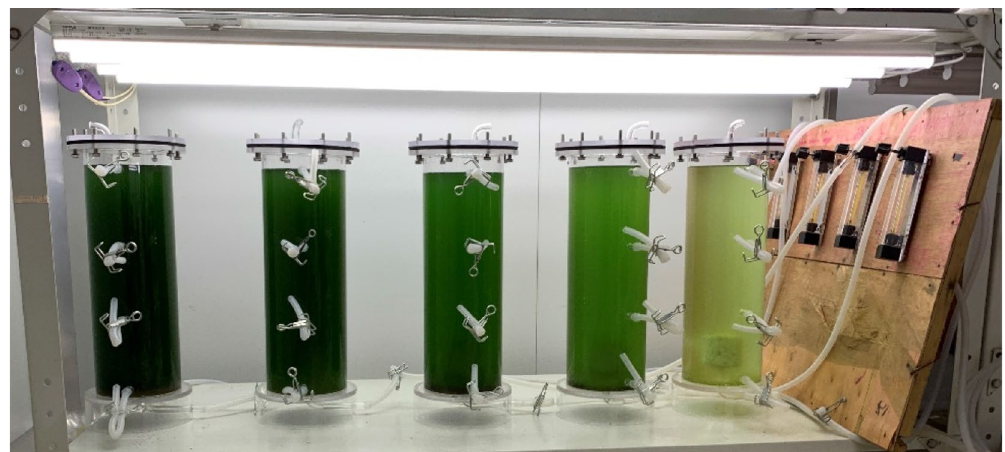
Figure 1. PSBR with Consortia with algae/sludge 10:1, 5:1, 1:1, 1:5 and 1:10 (donated as R1 to